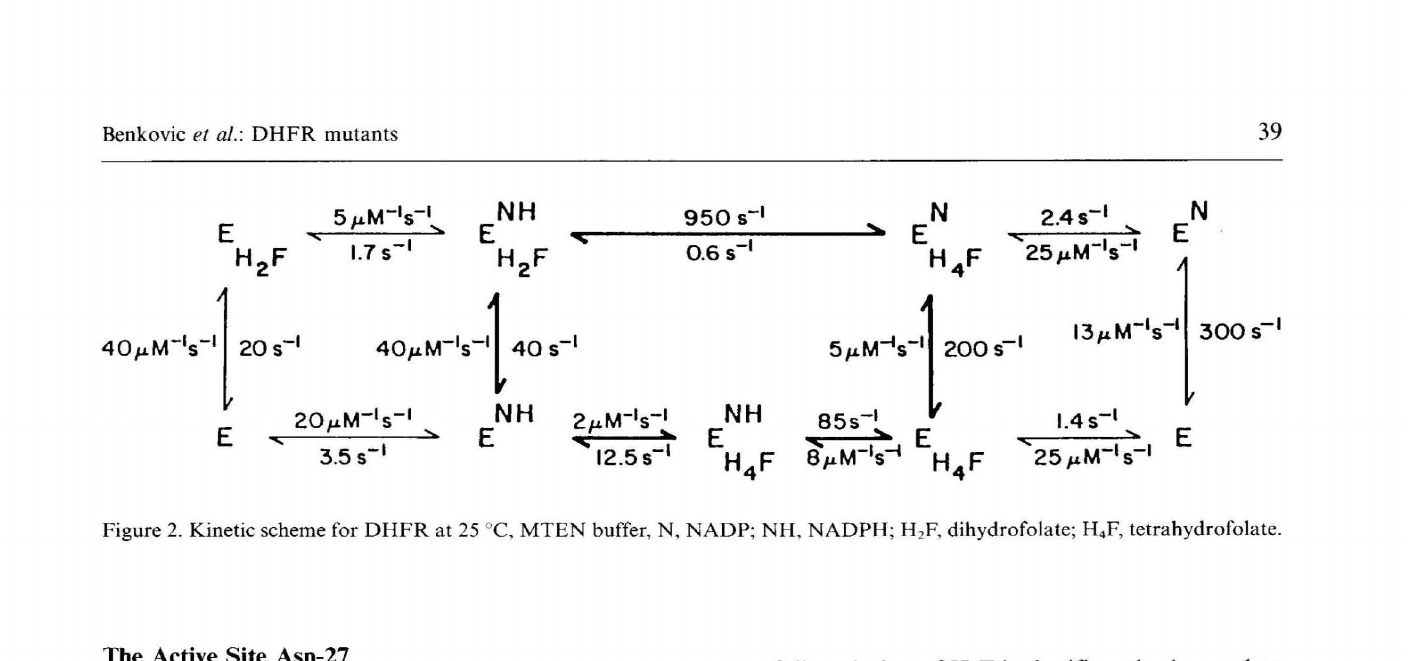
Figure 2. Kinetic scheme for DHFR at 2S 0c, MTEN buffer, N, NADP; NH, NADPH; H